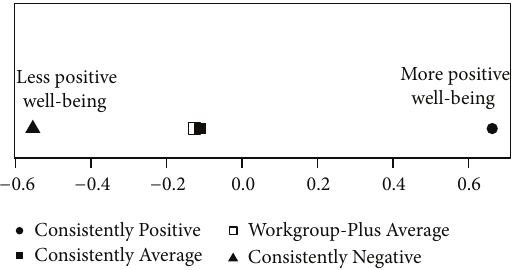
Figure 4: Sample 2 discriminant function analysis group